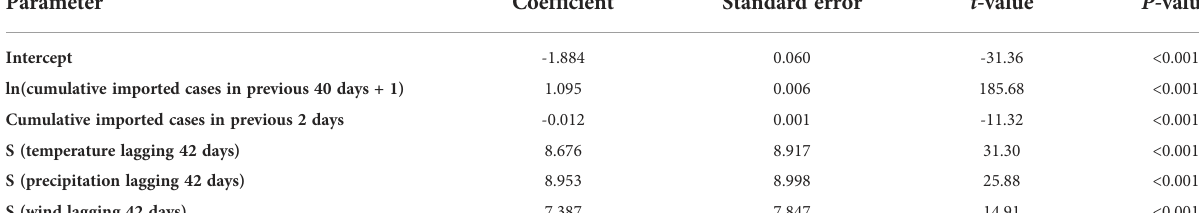
TABLE 1 Results of the Generalized Additive Models.